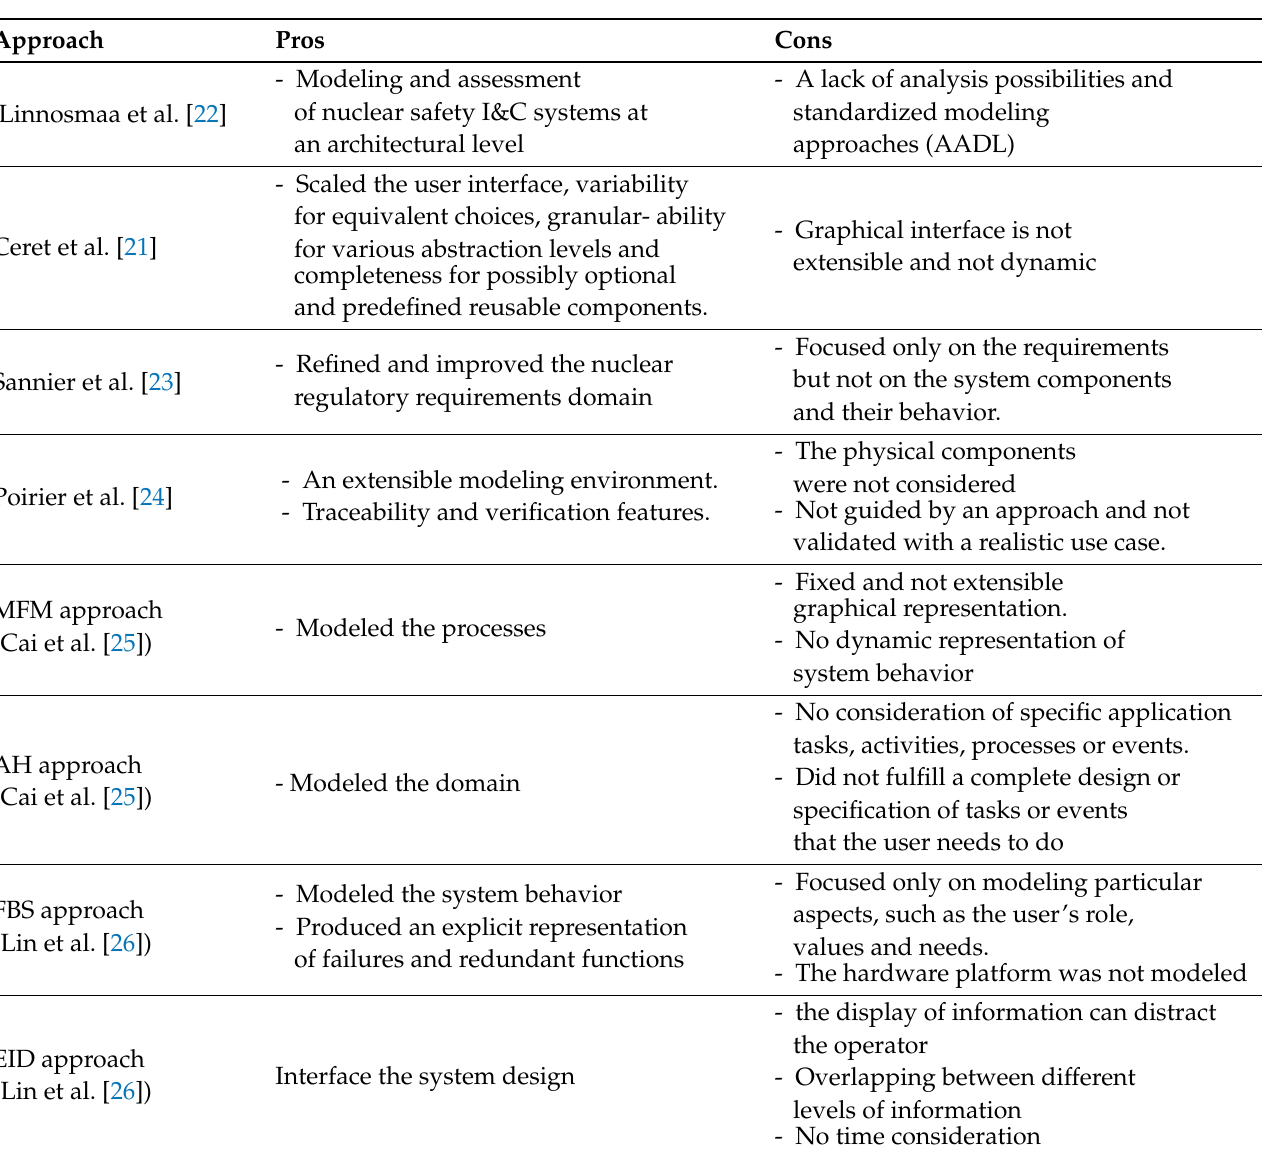
Table 1. Related works